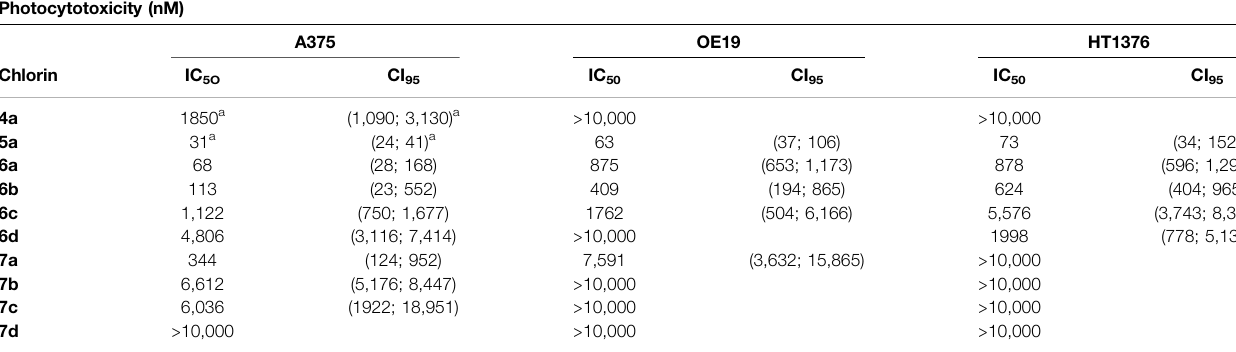
TABLE 2 | IC 50 values and con fi dence intervals at 95% (CI 95 ) values of chlorins 4a , 5a , 6, and 7 in human A375 skin malignant melanoma, OE19 esophageal adenocarcinoma,andHT1376urinarybladdercarcinomacells.Analysisperformed24 hafterPDTwithredlight(cutoff < 560nm)andenergyof10 J.Values,presented